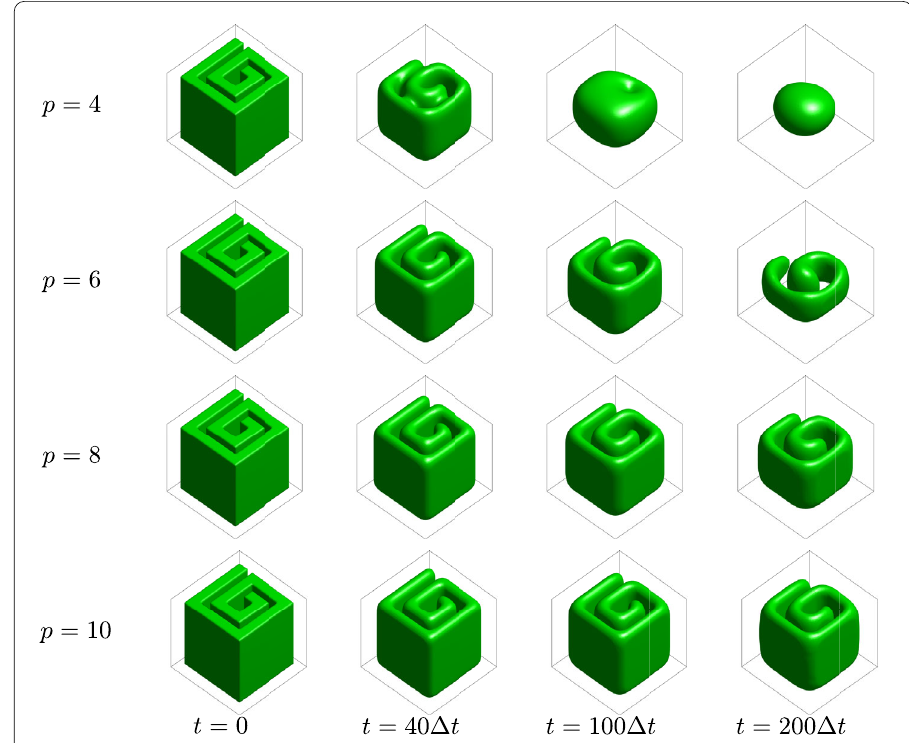
Figure 9 Evolution of φ ( x , y , z , t ) with (cid:7) x = (cid:7) y = (cid:7) z = 1